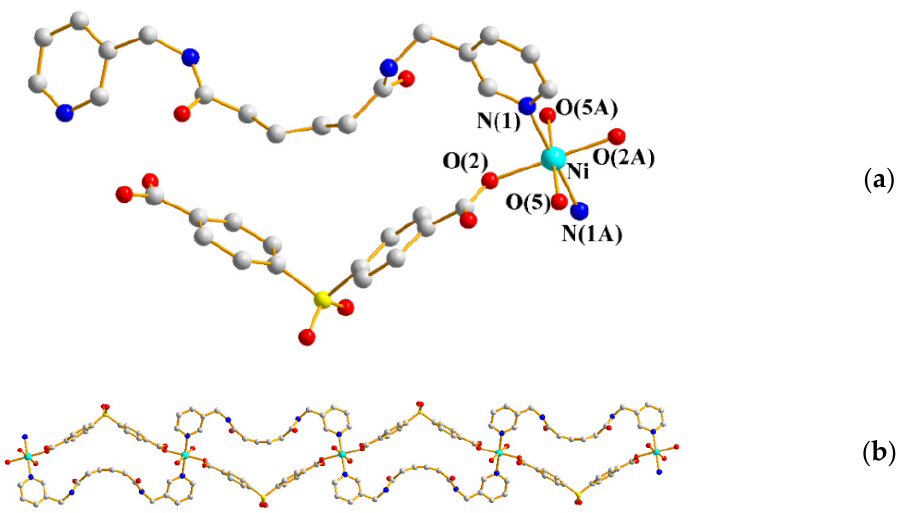
Figure 7. ( a ) Coordination environment of Ni(II) ion in 8 . Symmetry transformations used to generate equivalent atoms: (A) − x + 1/2, − y + 1/2, − z; (B) − x, y, − z + 1/2. ( b ) A drawing showing the 1D structure.